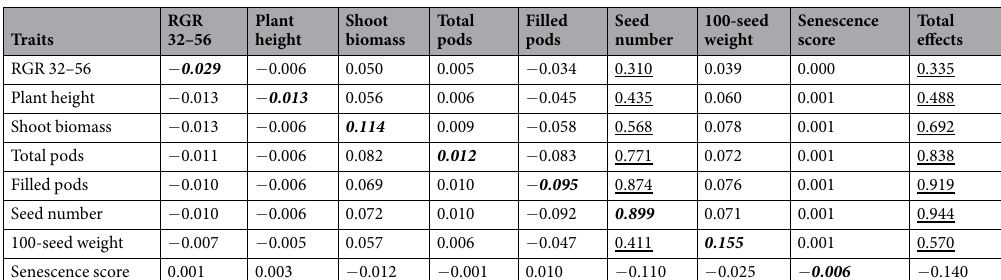
Table 4. Direct and indirect effects of yield components on salinity tolerance (salt/control), determined by partial least squares algorithm. Values in the main diagonal part (path coefficients) and off-diagonal part of the table represent direct and indirect effects of yield components on salinity tolerance. Total effects, which correspond to correlation coefficients, are derived from summing up direct and indirect effects. Highlighted are direct effects (bold) moderate indirect (underlined), as well as moderate to high total effects